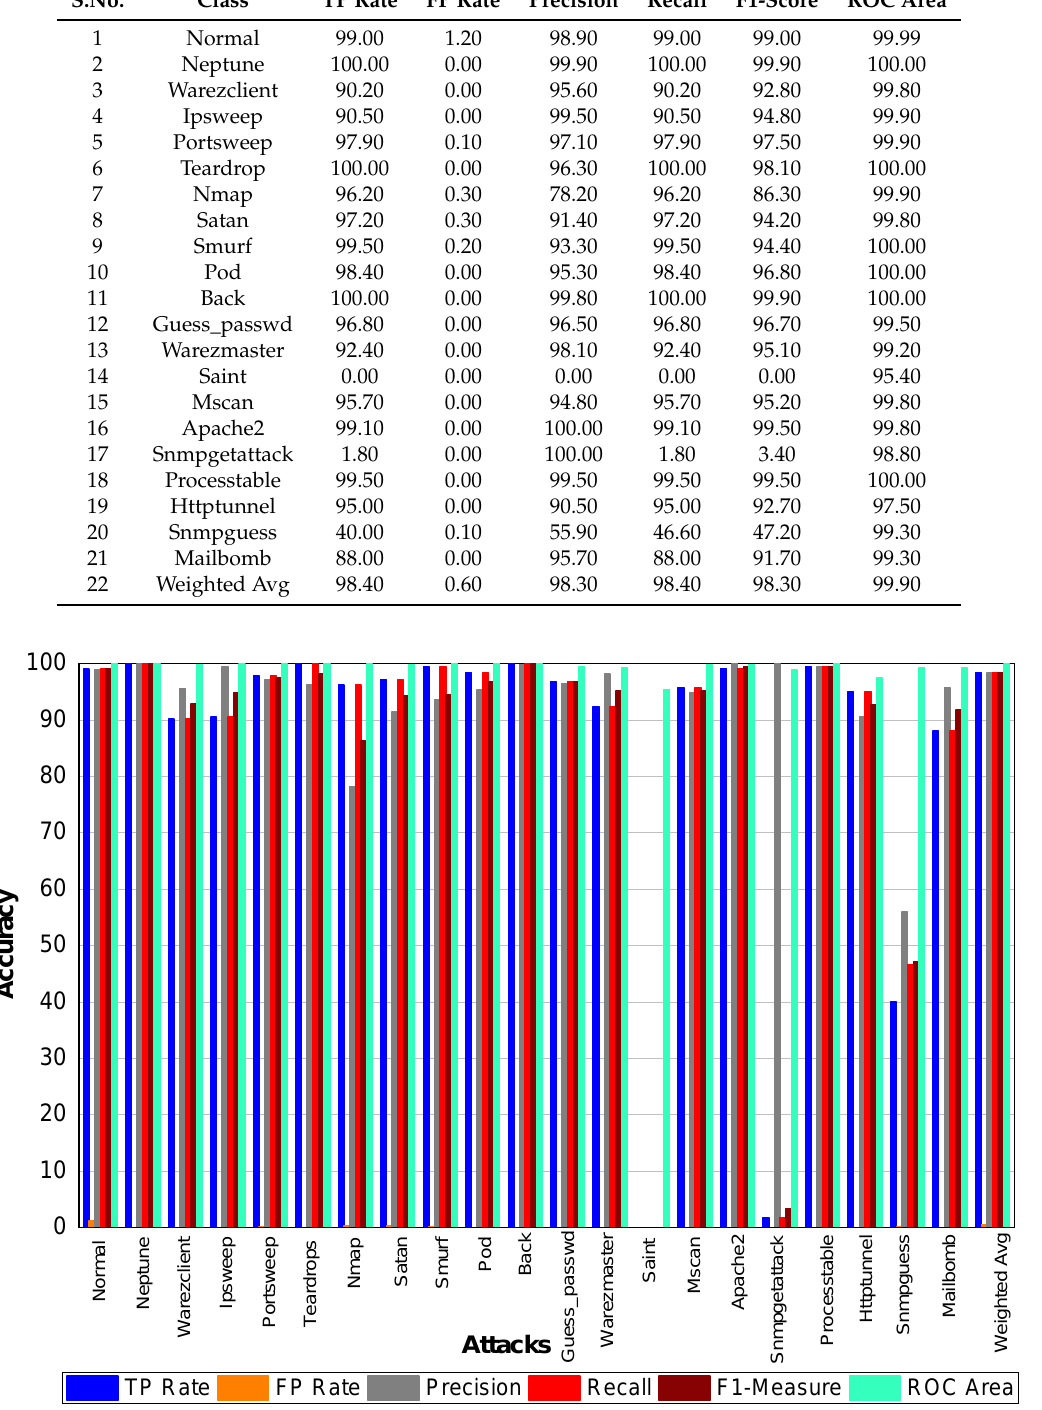
Figure 9. Classification report using the Adaboost J48 NSLKDD